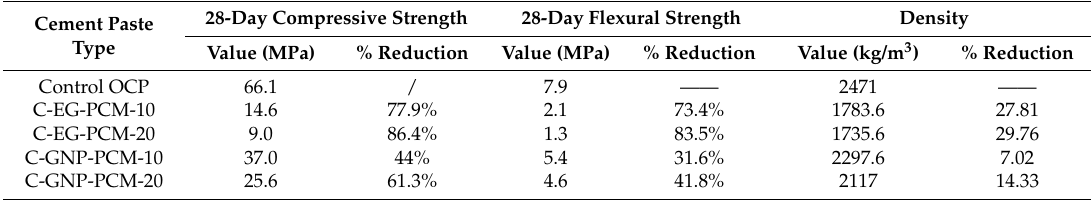
Table 3. The mechanical properties of cement pastes with the